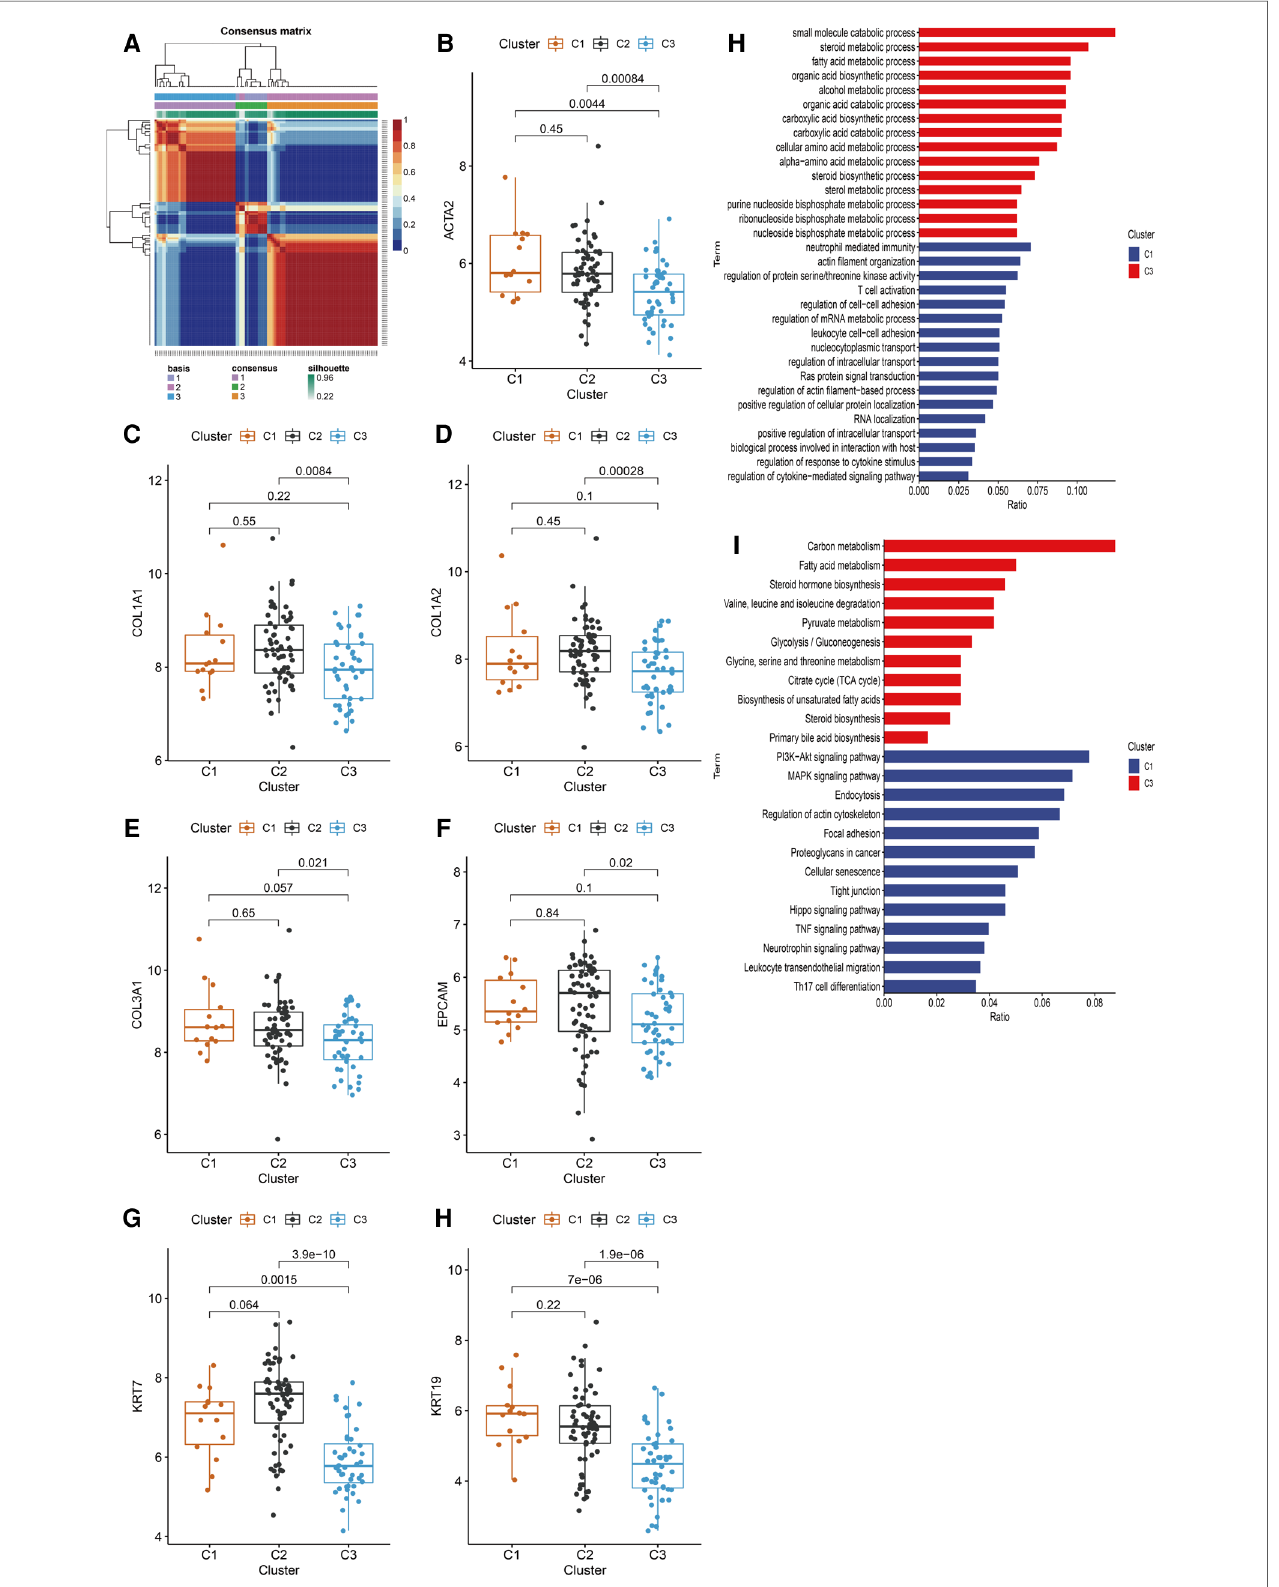
FIGURE 4 Identi fi cation of BA subtypes based on HSPGs expression levels. ( A ) NMF clustering heatmap when k =3. ( B – H ) The expression of ACTA2, COL1A1, COL1A2, COL3A1, EPCAM, KRT7 and KRT19 among three identi fi ed subtypes. ( I ) GO enrichment analysis of C1 subtype and C3 subtype. ( J ) KEGG pathway analysis of C1 subtype and C3 subtype. BA, biliary atresia; HSPG, heparan sulfate proteoglycan; NMF, non-negative matrix factorization; GO, gene ontology; KEGG; kyoto encyclopedia of genes and